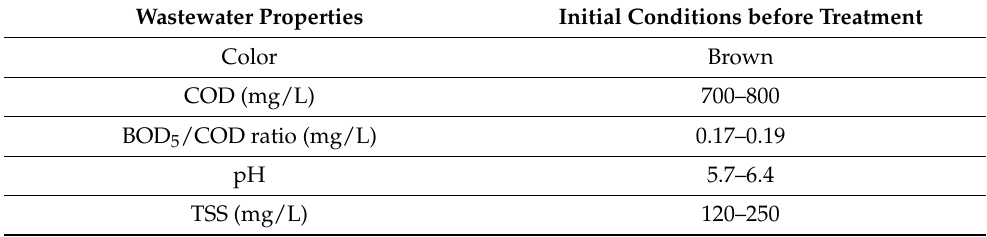
Table 1. Characteristics of licorice extraction plant